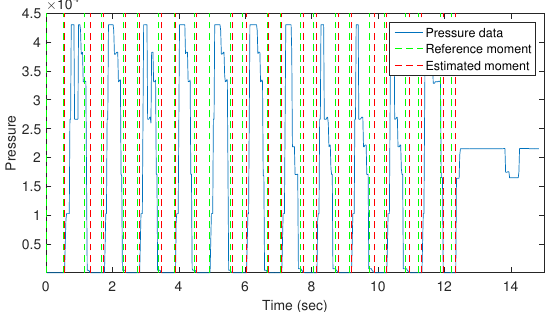
Figure 10. Determination of swing phases on a walking